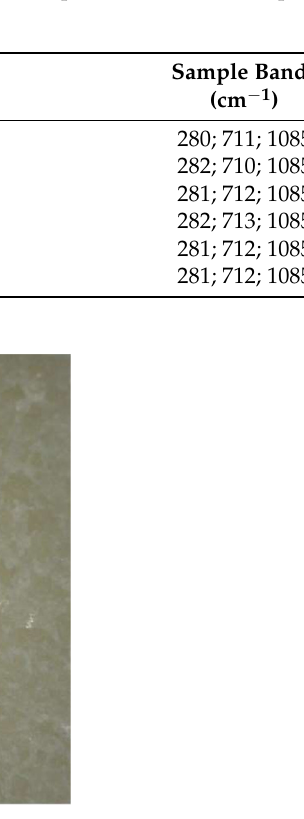
Appendix B. All spectra match with those of calcium carbonate (USGS Calcite WS272) (https: //crustal.usgs.gov/speclab/QueryAll07a.php accessed on 30 March 2022), and no